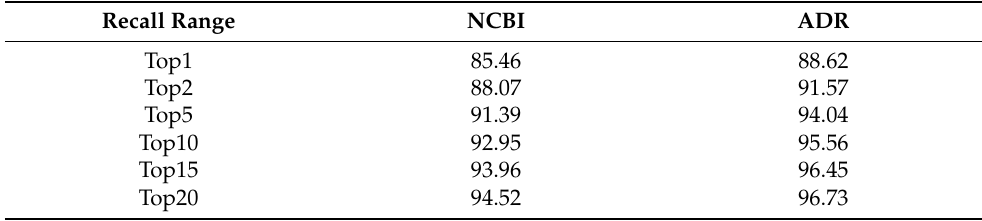
Table 3. Comparison of candidate entity generation results in different recall ranges.